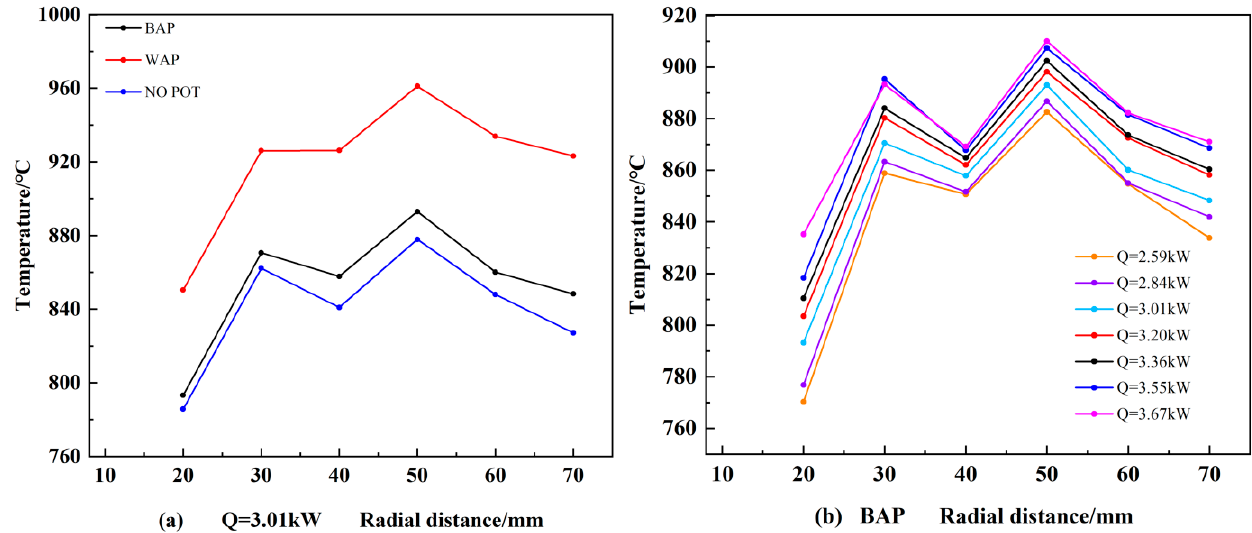
Figure 4. Surface temperature of PCP. ( a ) The surface temperature of PCP under different operating conditions under heat load is 3.01 kW. ( b ) The surface temperature of PCP with BAP under different heat loads.